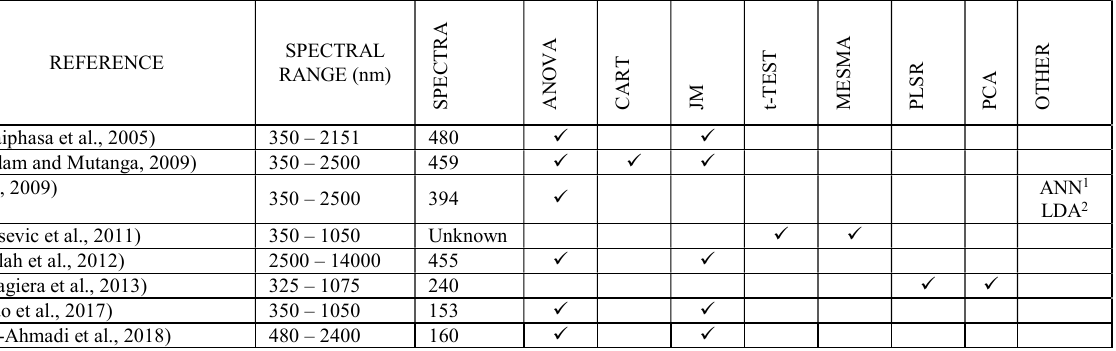
Table 1 - Summary of successful spectral separation methods from literature review